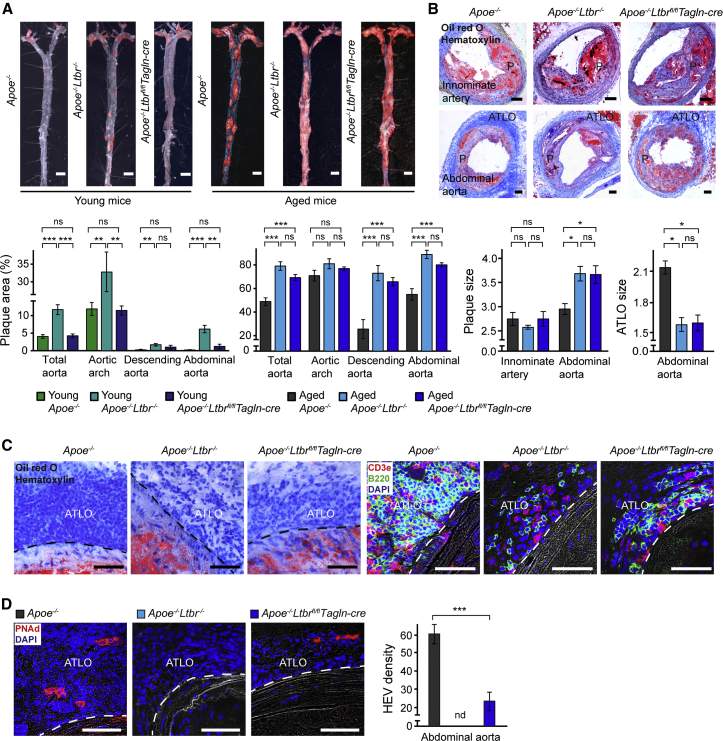
VSMC-LTβRs Protect against Atherosclerosis(A and B) Atherosclerotic plaque and ATLO sizes. Sudan-IV-stained aortas of young (32–35 weeks; n = 3) and aged (78- to 85 weeks old; n = 4–6) mice (A, upper panel), and Oil red O/hematoxylin stained innominate arteries (n = 3–8) and abdominal aortas (n = 4–8) (B, upper panel). Atherosclerotic lesions in different parts of the aorta were quantified as percentage of plaque areas (n = 3–6 mice per genotype (A, lower panels); plaque (P) sizes and ATLO sizes in different aorta segments were quantified as percentage of plaque areas, intima/media, and ATLO/media ratios, respectively (n = 5–10 sections in 3–8 mice per genotype) (B, lower panels).(C and D) Effect of Ltbr deletion on the ATLO structure. Histological and immunofluorescence stainings show ATLO cellularity (C) and HEV abundance (D) in abdominal aorta segments (n = 5–8 sections in n = 3–4 mice per genotype). Scale bar represents 2.5 mm (A); 100 μm (B); and 50 μm (C and D). Data represent means ± SEM; p values were determined by two-tailed Student’s t test or by multiple testing (Bonferroni) using the GEE model as described in the Supplemental Experimental Procedures. ∗p < 0.05; ∗∗p < 0.01; ∗∗∗p < 0.001; ns, not significant, p > 0.05; nd, not detectable.